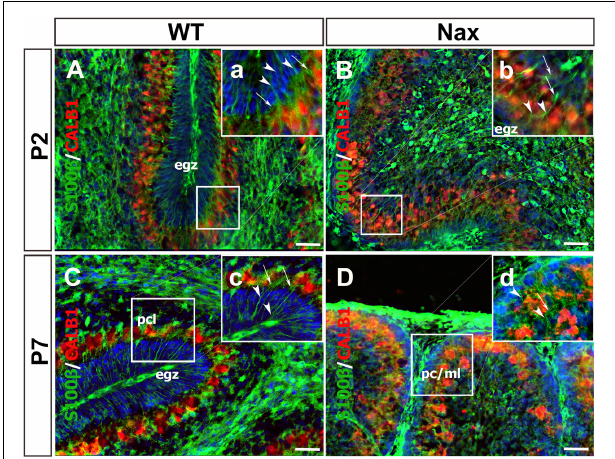
FIGURE 2 | Close relation of BGCs and PCs at P2 and P7 in wt and nax littermate cerebellum. (A–D) Sagittal section of the cerebellum at P2, and P7 were immunofluorescence labeled with anti-calbindin (red) (CALB1; specific marker for PCs) and anti-S100 β (green) (specific marker of BGCs). (A,B) Images show multiple layers of PCs and the BGC soma at P2 in both wt (A) and nax (B) cerebellum. The BGC fibers (arrowhead in high magnifications a,b ) are extended from basal end and pass the cluster of PCs’ (arrow in high magnifications a,b ) intercellular space where BGC soma is located. In other word, the extension ends in pial surface and the BGC soma are located in PCs cluster. (C,D) The location of BGCs (arrowhead in high magnifications a,b ) is shown at P7 among PCs in PC layer of wt cerebellum (C) . BGCs and their fibers are located in nax cerebellar sections in PC/molecular layer close to EGZ (D) . The BGC fibers in nax cerebellum are not well organised as in wt cerebellum, but still basal end are connected to the pia matter through their fiber extensions. PCs, Purkinje cells; BGCs, Bergman glia cells; pcl, Purkinje cell layer; ml, Molecular layer. Scale bars: 100 µ m (applies to panels A–D ); 50 µ m (applied to panels a–d